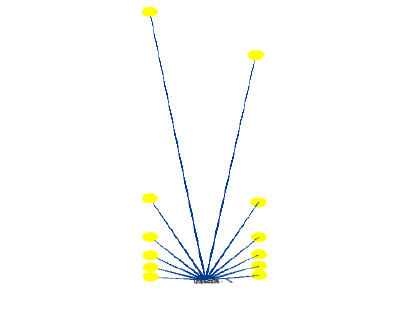
Figure 8. Sun Points Model